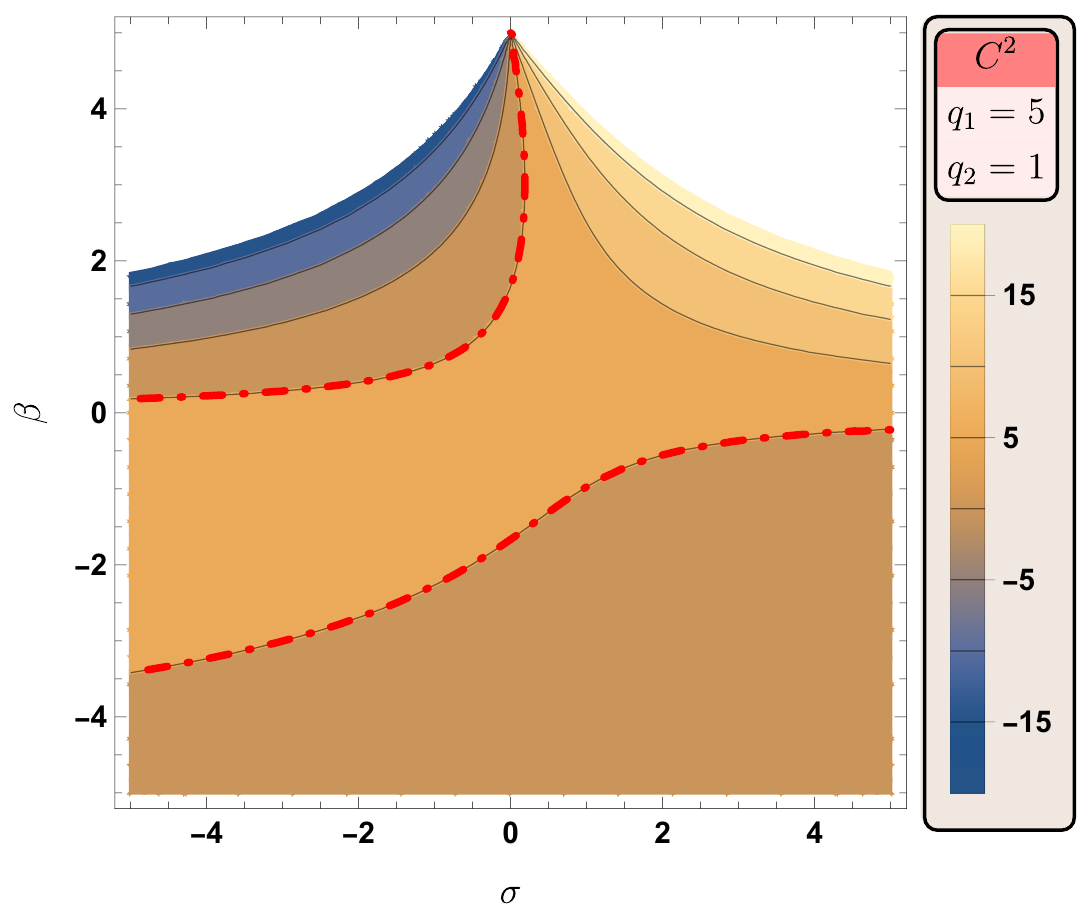
Figure 2 . Plot of C 2 , (6.3), for q 1 = 5 , q 2 = 1 , as a function of σ and β . The red dashed-dotted lines indicates the C = 0 contour. In the region between them is where the values are positive. C 2 determines the size of the ψ circle at infinity, in the asymptotically AdS